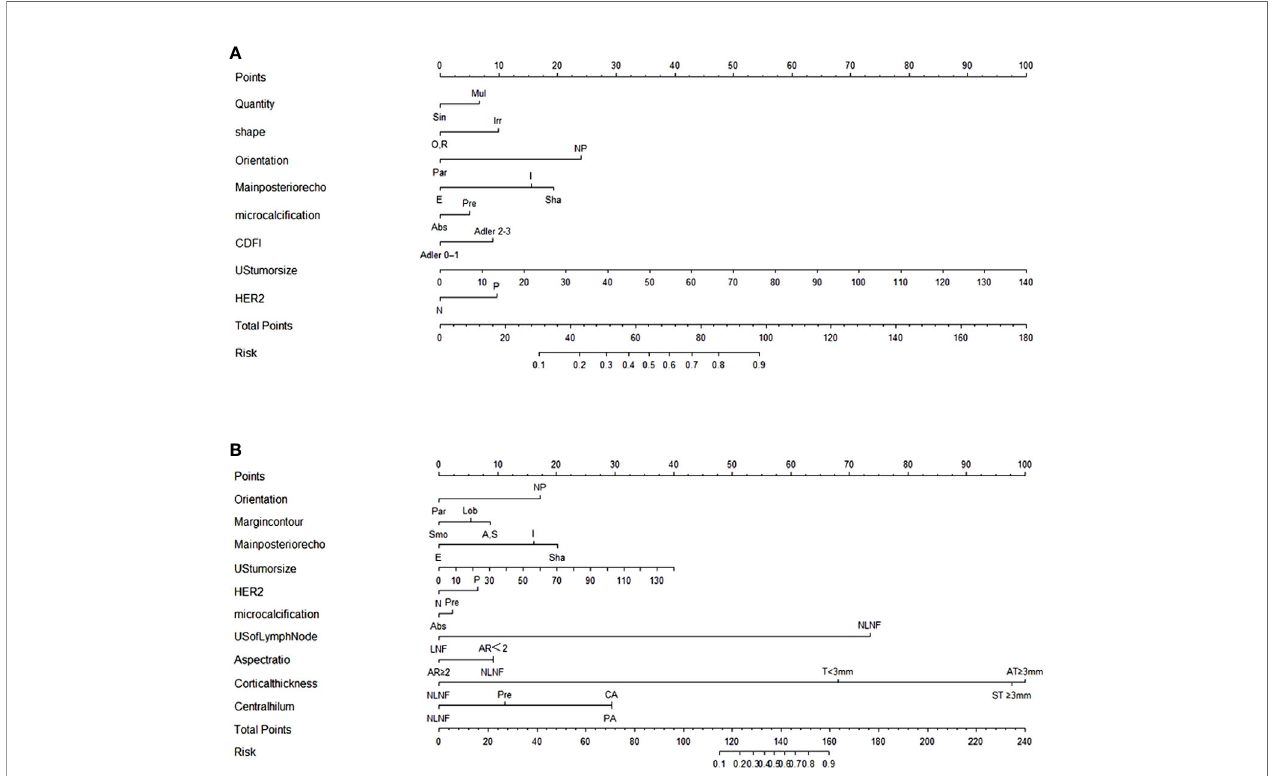
FIGURE 2 | (A) The PTFM nomogram for predicting ALN status in the training set. (B) The ALNFM nomogram for predicting ALN status in the training set. Sin, Single; Mul, Multiple; O, Oval; R, round; Irr, Irregular; Par, Parallel; NP, Not parallel; Smo, Smooth; Lob, Lobulate; A, Angular; S, Spiculate; E, Enhancement; I, Indifferent; Sha, Shadowing; Abs, Absent; Pre, Preserved; N, Negative; P, Positive; NLNF, No lymph nodes found; LNF, Lymph nodes found; AR, Aspect ratio; T, Thickness; ST, Symmetric thickness; AT, Asymmetric thickness; PA, Partially absent; CA, Completely